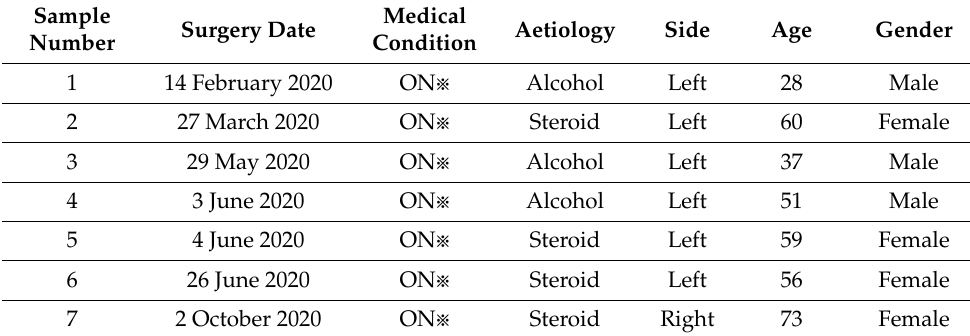
Table 1. Femoral heads information with osteonecrosis. ※ ON: Osteonecrosis.